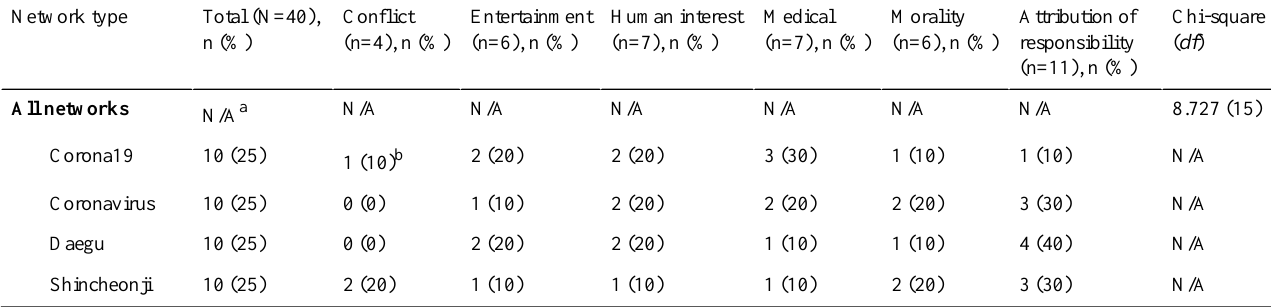
Table 3. Chi-square results for the news frames across coronavirus disease networks.